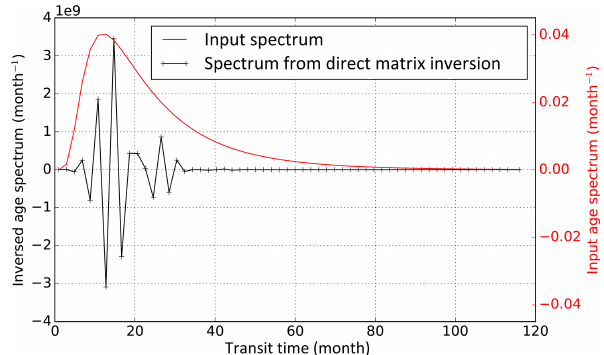
Figure A1. Age spectrum from a direct inversion (Eq. A1) using a set of radioactive tracers (black) vs. input age spectrum (red). Note that due to the huge amplitude of the characteristic oscillations asso- ciated with the ill-posed, underconstrained problem, different y axes are used for the inversed and input age